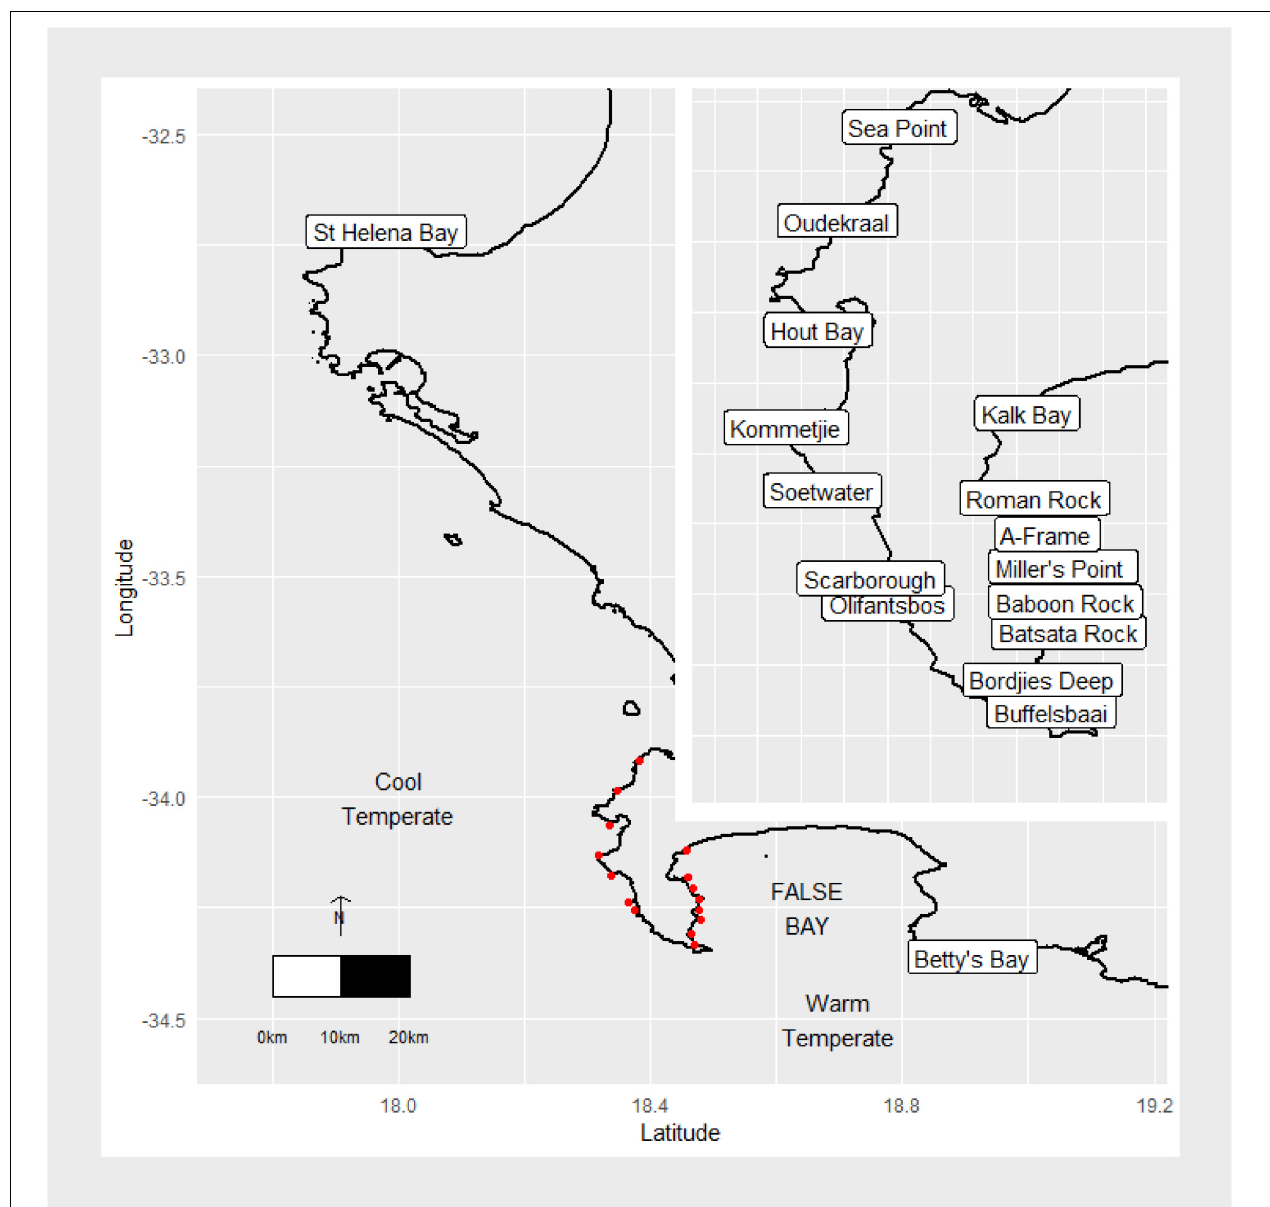
FIGURE 1 | Map of the study area and sampling sites. The red dots represent study sites around the Cape Peninsula.